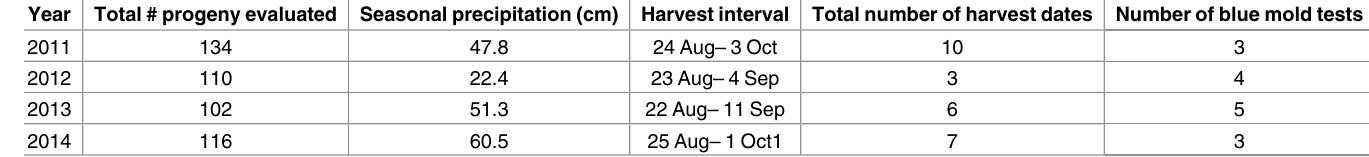
Table 1. Summaryof apple fruit harvested from progeny of the GMAL4593 mapping population and used for the evaluation of resistance to blue mold postharvest decay.